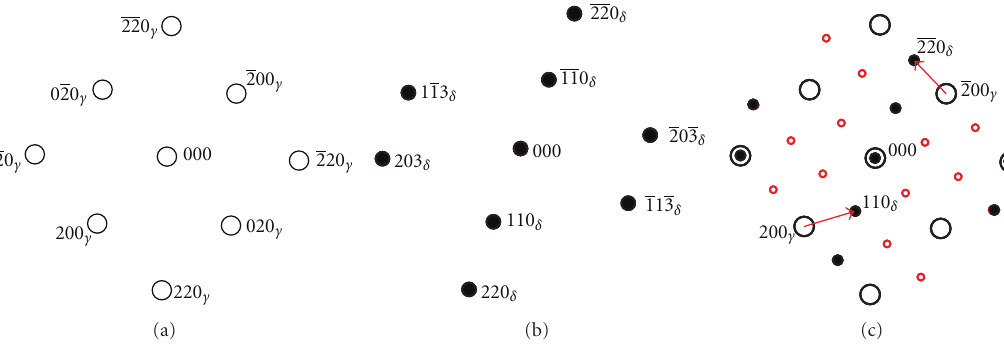
Figure 12: Indexing of the SAD pattern shown in Figure 8(b), indicating that the pattern can be obtained by the superimposition of di ff raction along [001] γ (a) and [332] δ 1 (b) plus some additional spots arising from double di ff raction as shown by the arrows in